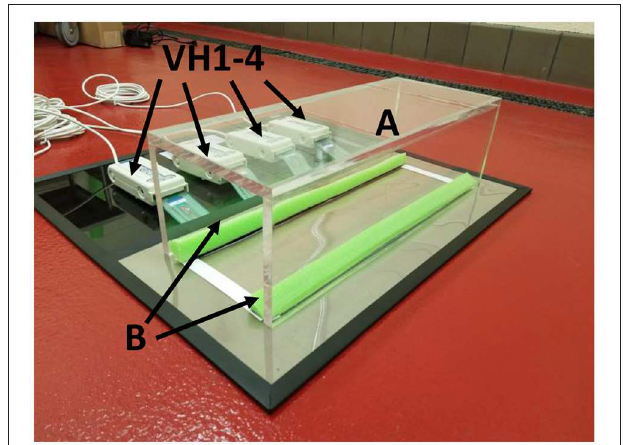
FIGURE 1 | Tekscan VH4 pressure-mat system setup. Testing apparatus consists of a tinted Plexiglas tunnel (A) . The tunnel is positioned over the Tekscan pressure mat aligned to Styrofoam borders placed at the edges of the sensor area (B) . Four sensors (VH1–4) connect the four 5,101 grids to the Tekscan